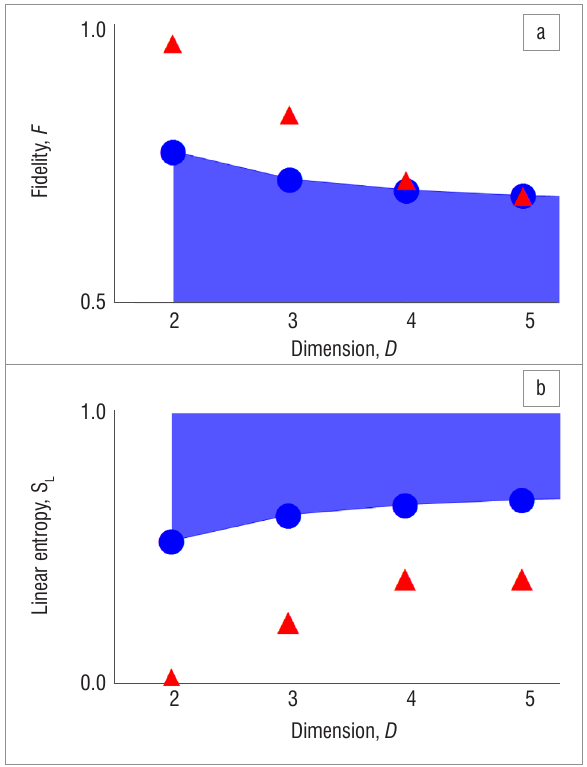
Figure 9: (a) Fidelity and (b) linear entropy as a function of dimension. The red triangles represent the experimental measurements, while the blue shaded area represents the states that will not violate the appropriate high-dimensional Bell inequality. The results indicate that the degree of entanglement decreases as the dimensionality increases; however, the results do not fall below the